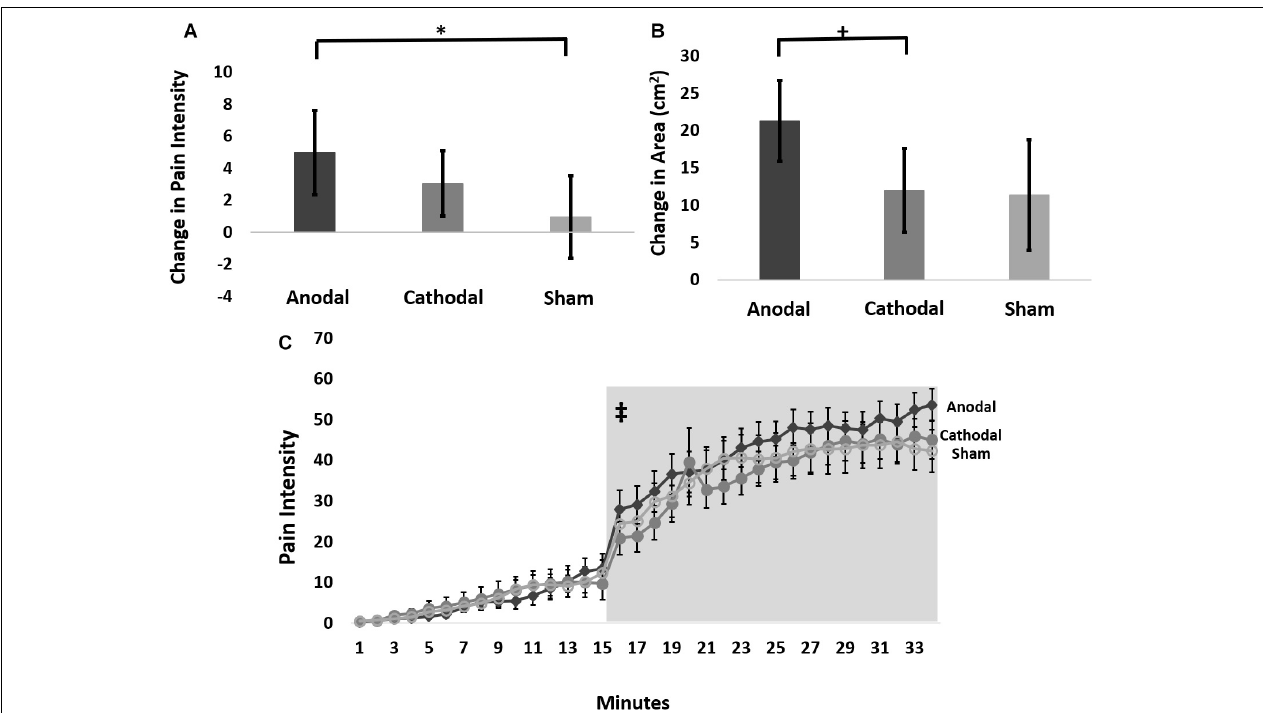
FIGURE 3 | (A) Average change in pain intensity (delta scores) from 15 to 65 min grouped by intervention type and collapsed across probe force (128, 256, and 512 mN) ( ∗ anodal > sham p = 0.02). (B) The change in area of pinprick hyperalgesia (delta score) from 15 to 65 min grouped by intervention type (+ anodal > cathodal p = 0.075). (C) Time course of pain ratings during capsaicin mediated heat allodynia. Anodal (dark gray), cathodal (medium gray), or sham tDCS (light gray) began 12 min after capsaicin application, and the thermode temperature ramped up to the individualized target temperature at 15 min after capsaicin application. Light gray box demarcates post-treatment time course where pain intensity ratings were significantly higher during anodal compared to sham stimulation. ‡ = anodal > sham stimulation p = 0.0009. Error bars are